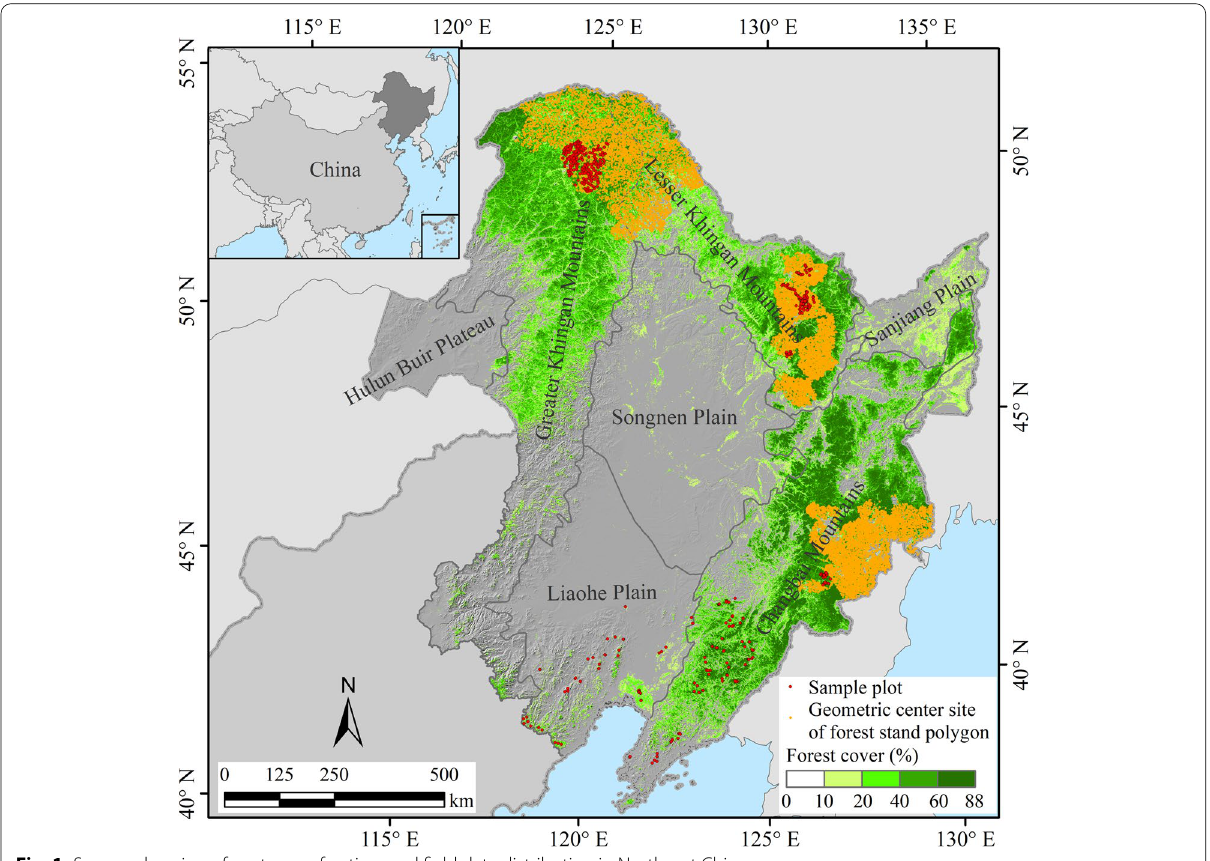
Fig. 1 Seven subregions, forest cover fraction, and field data distribution in Northeast